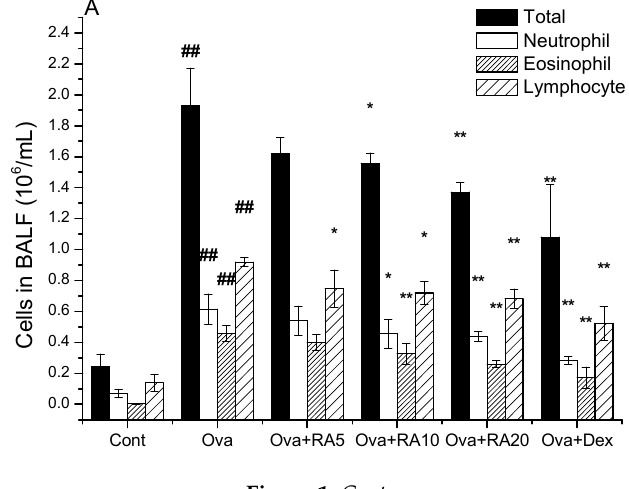
Figure 1. Cont. Figure 1.